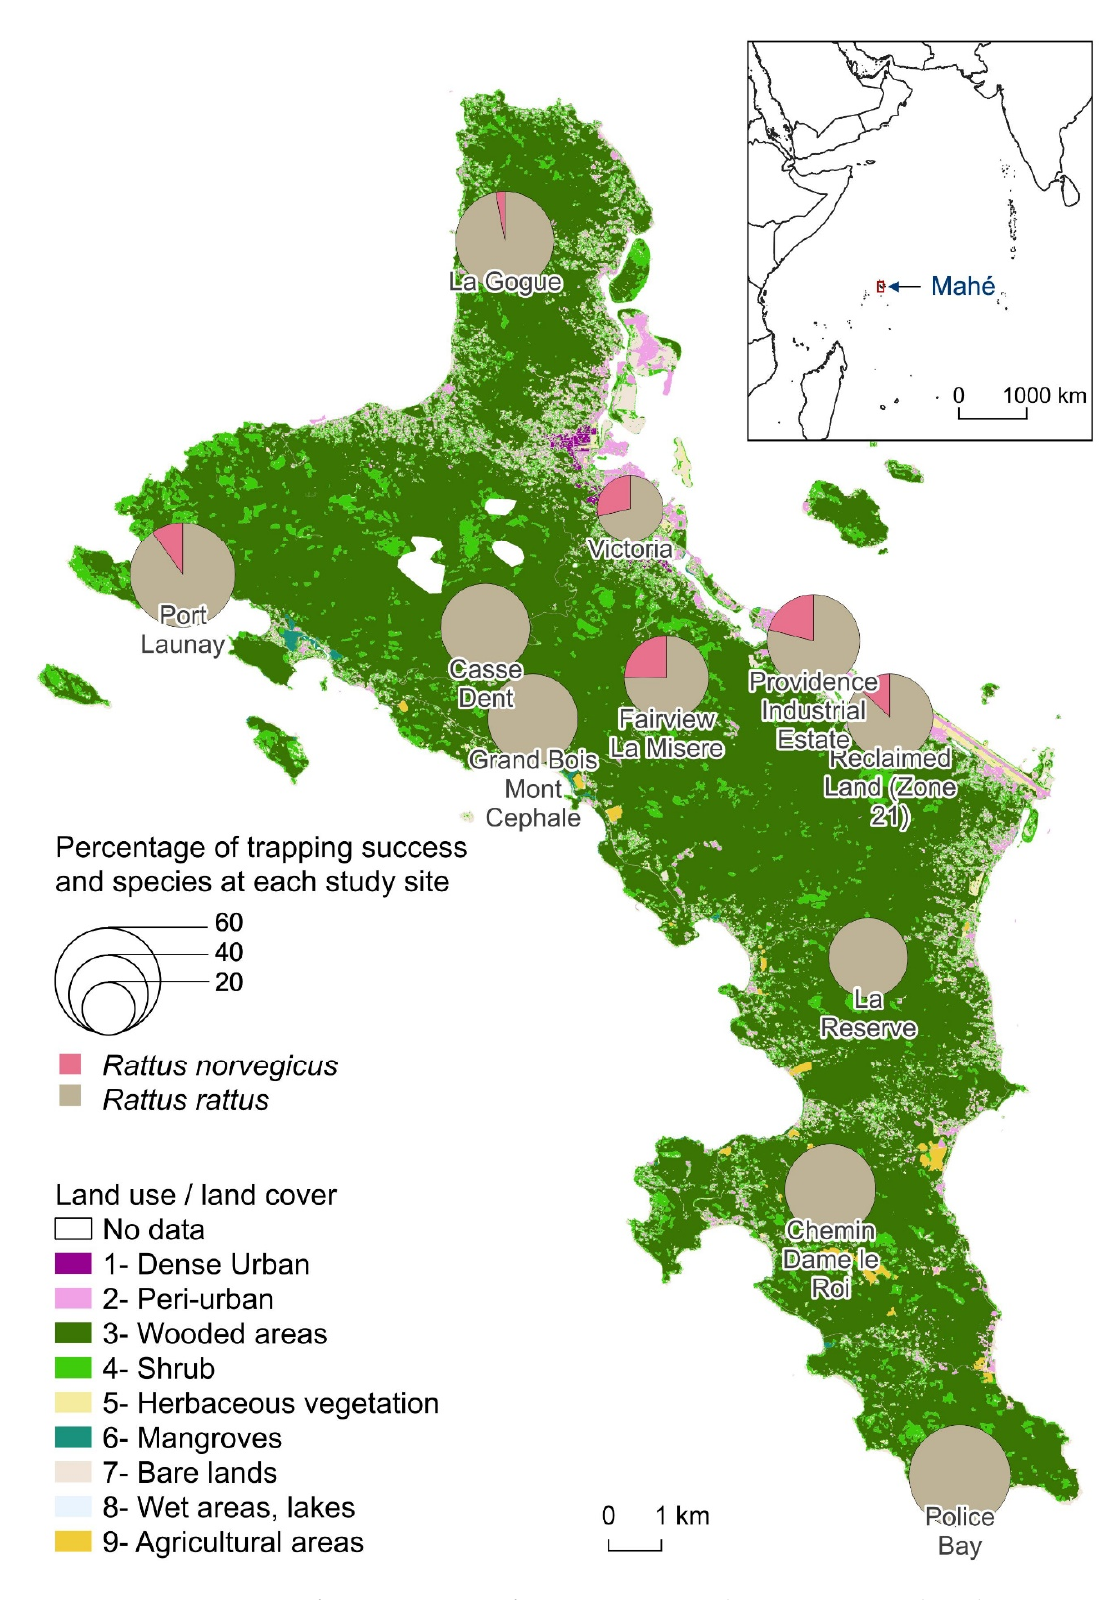
Figure 1. Percentage of trapping success of Rattus norvegicus and Rattus rattus at each study site.